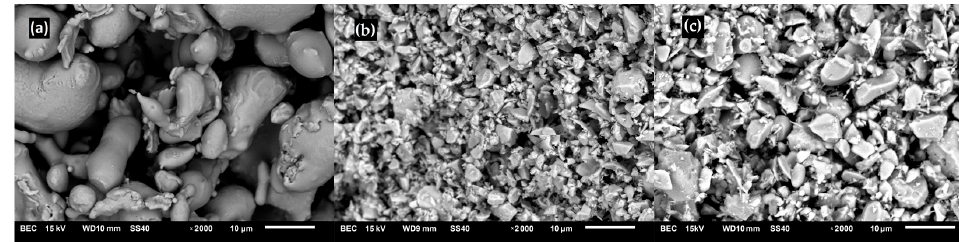
Figure 1. SEM images of raw materials. ( a ) 316L austenitic stainless steel, ( b ) diboride zirconium, and ( c ) diboride titanium.